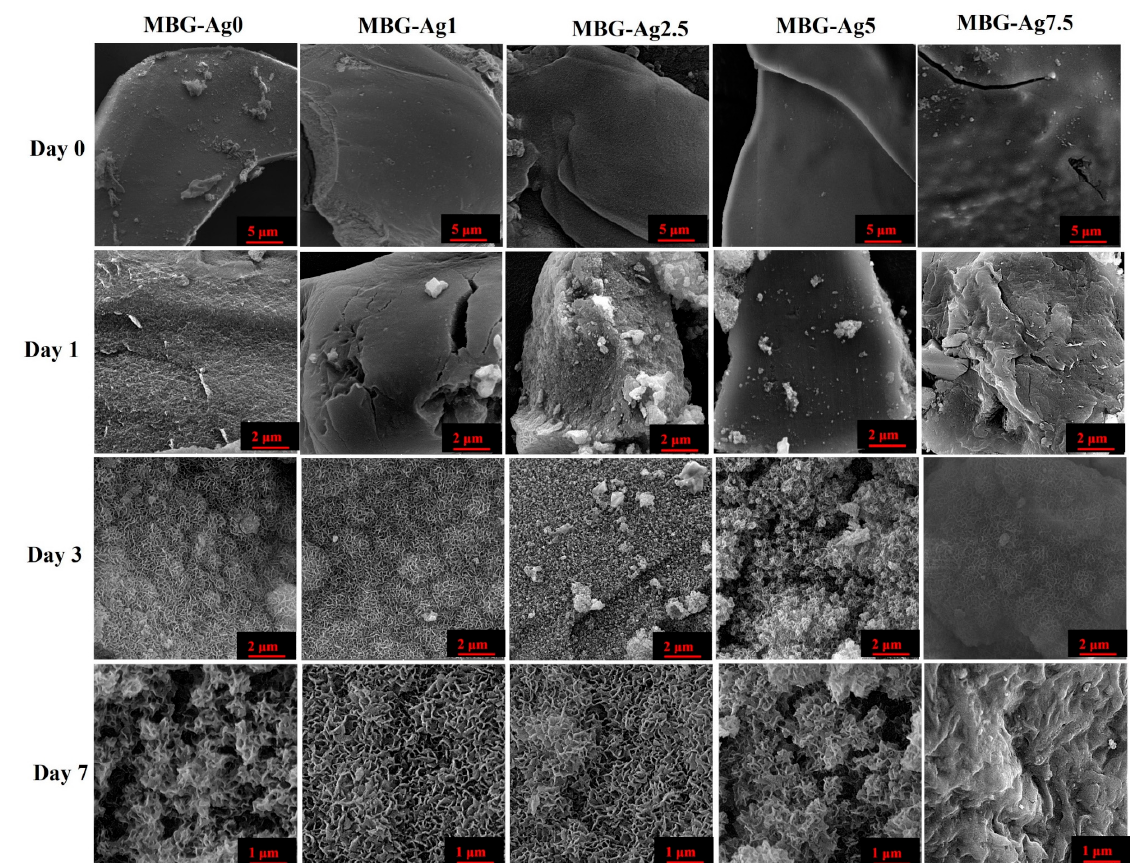
Figure 6. FESEM images of un-doped and Ag-doped MBGs before and after immersion in SBF.